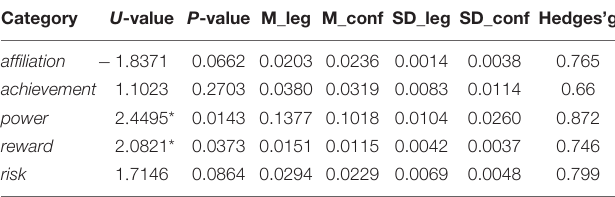
M_leg and M_conf columns show the average frequencies of each word category, respectively, in Legalist and Confucian classics. SD_leg and SD_conf stand for the standard deviations of the frequencies of each word category, respectively, in Legalist and Confucian classics. Hedges’g represents the effect size of each word category. As we can see, the effect size of power words is the largest. *P <